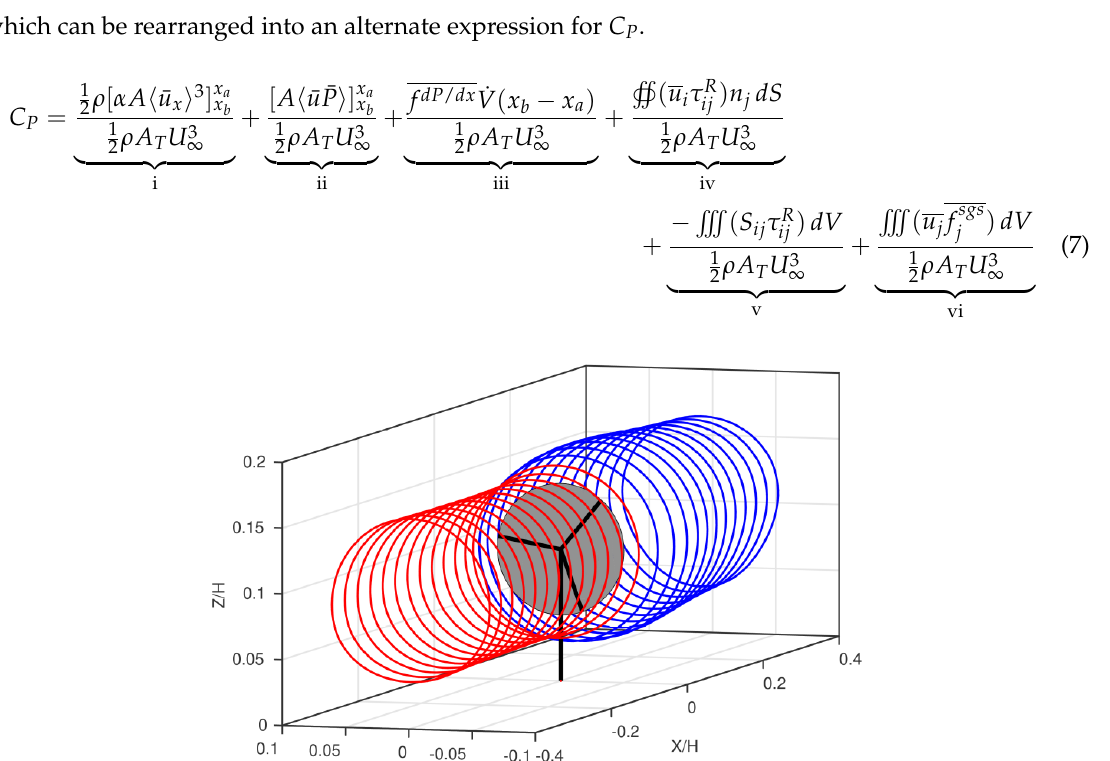
Figure 1. Example of streamtube control volume with actuator disk shown in gray. Upstream streamtube sections are plotted in red, and downstream in blue. Spatial axes are normalized by the domain height, H